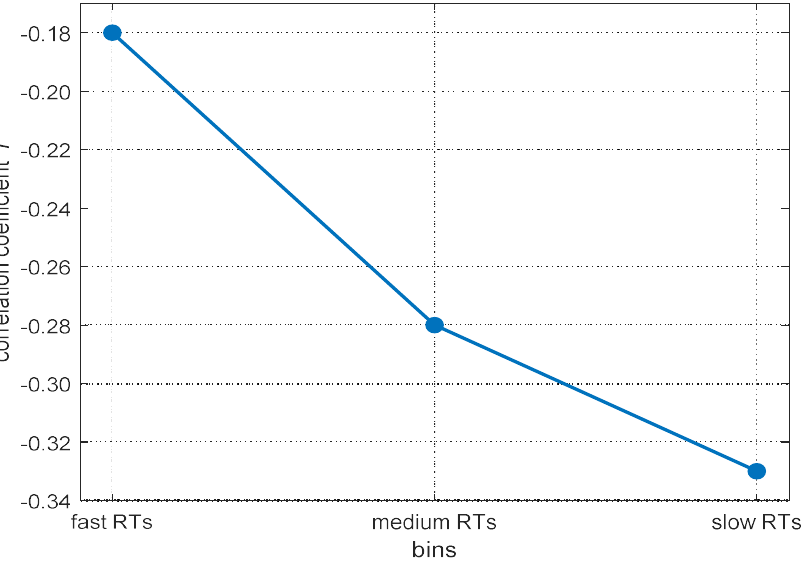
Figure 1. An example for the increasing magnitude in correlations between RT and mental abilities from fast to slow RT-bins. Data are based on the meta-analysis from Schubert (2019).